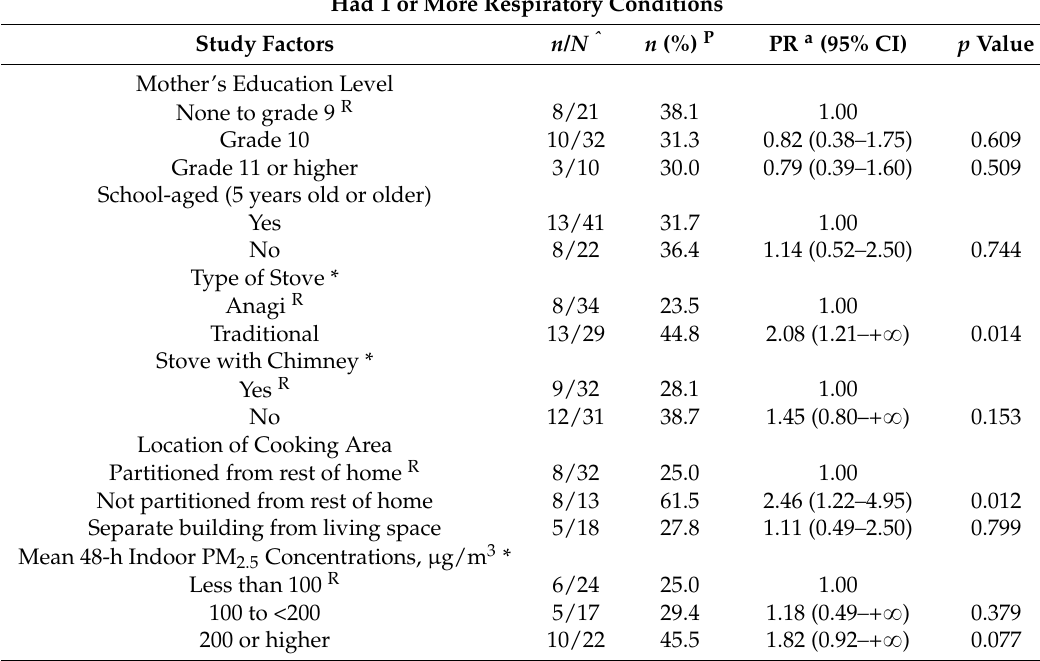
Table 4. Prevalence ratios for respiratory conditions among children by demographic and household exposure